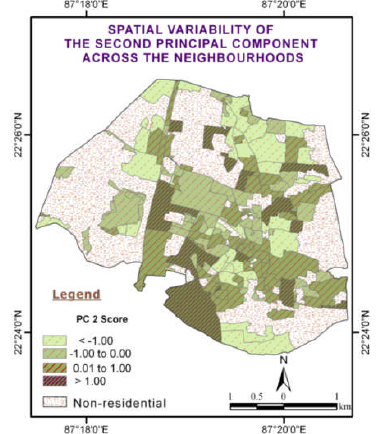
Figure 3. Second Principal Component with